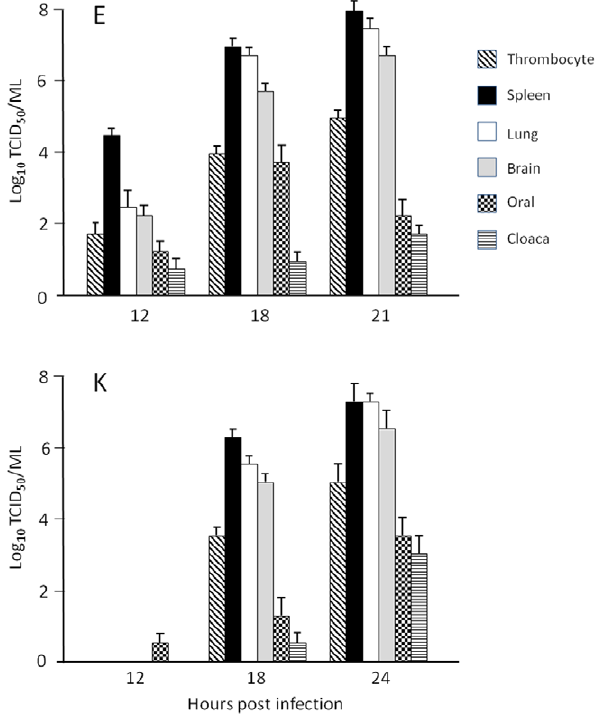
Figure 3. Virus isolation from tissues of infected ducks. Virus titers in spleen, lung and brain samples and from oropharyngeal (oral) and cloacal (cloaca) swabs collected from ducks infected with HP VN/ 1203/E and HP VN/1203/K at 1, 2, 3, 4, and 6 days pi. All titrations were performed in Vero cells. Data show mean and SEM of 6 birds per time point for each